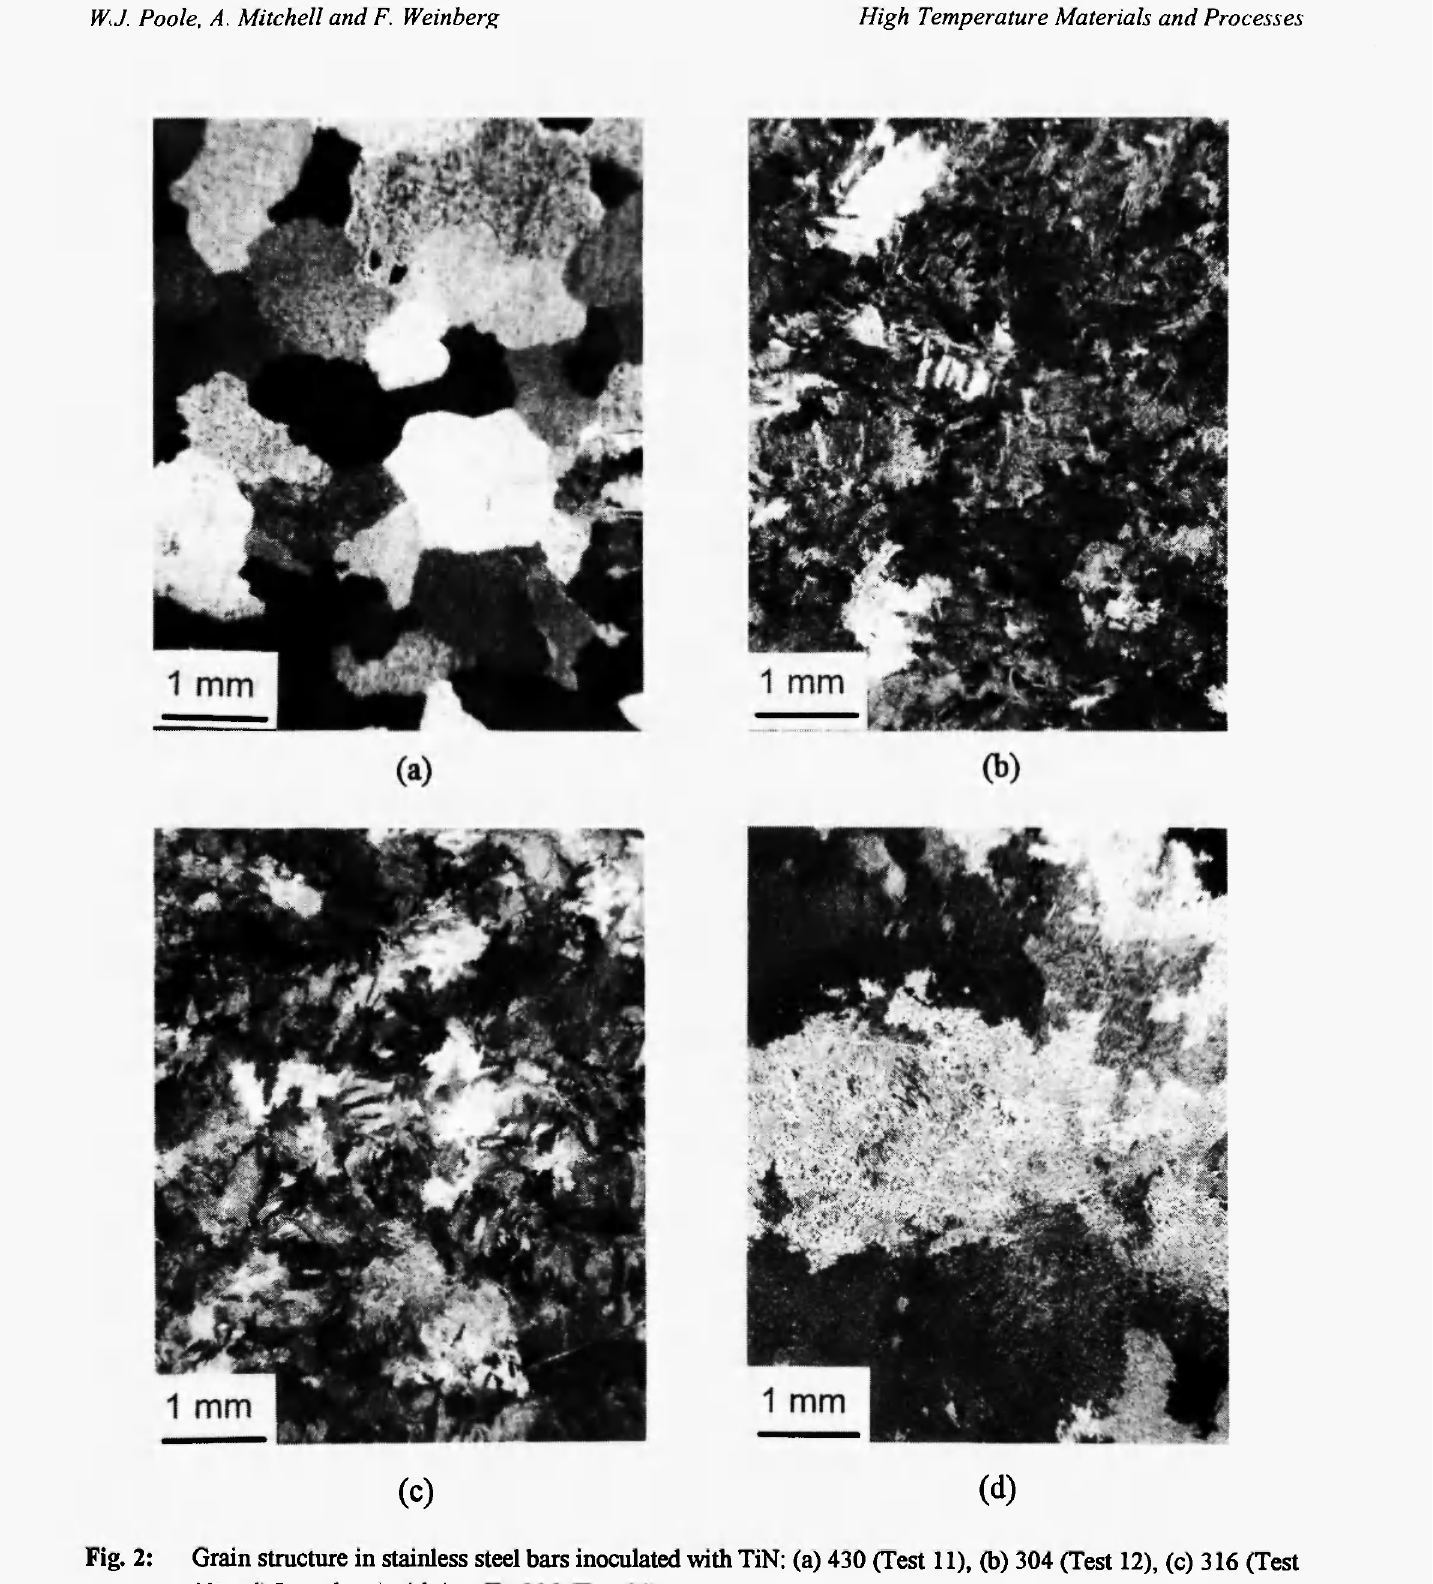
Fig. 2: Grain structure in stainless steel bars inoculated with TiN: (a) 430 (Test 11), (b) 304 (Test 12), (c) 316 (Test 13), (d) Inoculated with less Ti: 316 (Test